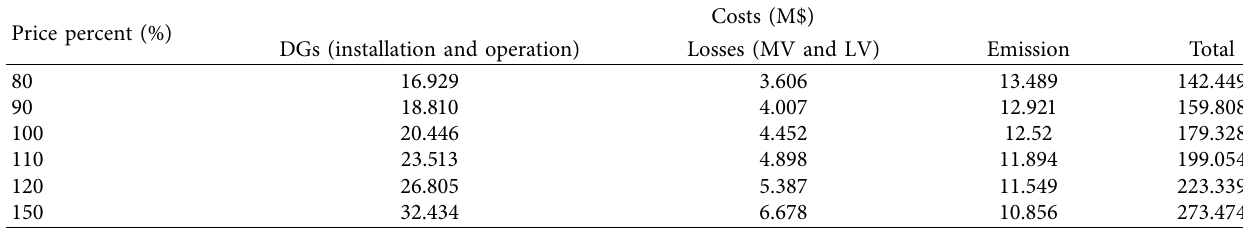
Table 13: Sensitivity analysis on price of electric energy.